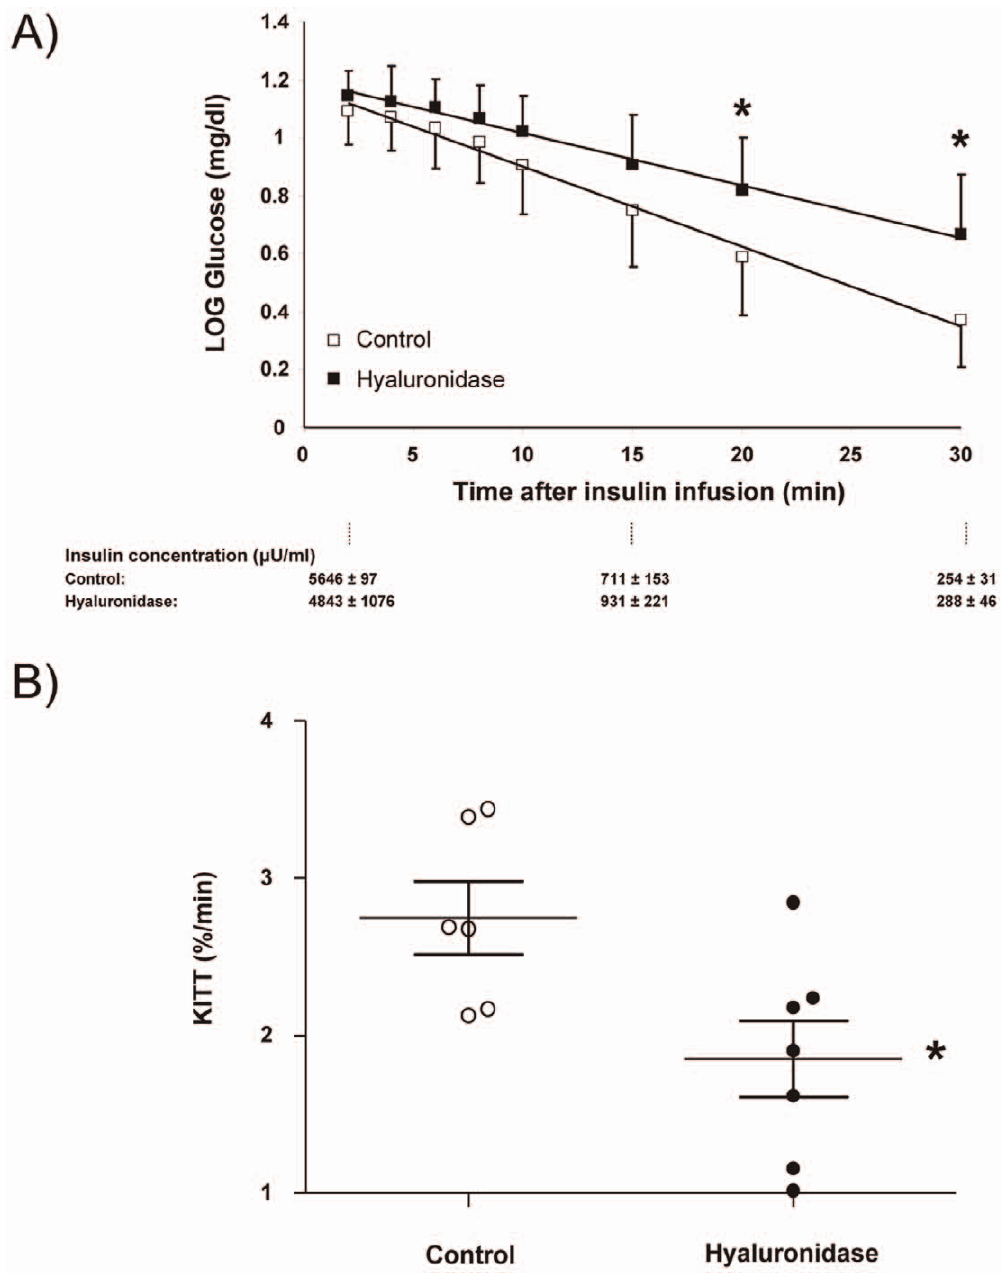
Figure 2. Mean ± SEM of the logarithm of blood glucose in time after an i.v. bolus of insulin (1 U/kg) in control rats (n=6) and hyaluronidase treated rats (n=7) are shown in panel A. Insulin levels (in m U/ml) measured at different times during the test are shown in the panel below the graph.*, P , 0.05 versus control (unpaired student’s t-test). The glucose disposal rate (Kitt), calculated from the slope of the linear regression line of the logarithm of blood glucose against time multiplied by 2 100, for each individual experiment as well as the mean 6 SEM of all experiments are shown in panel B *, P , 0.05 versus control (unpaired student’s t-test).